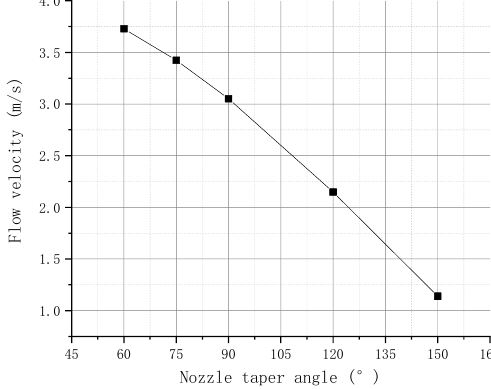
Figure 9. Flow velocity in different nozzle taper angles.